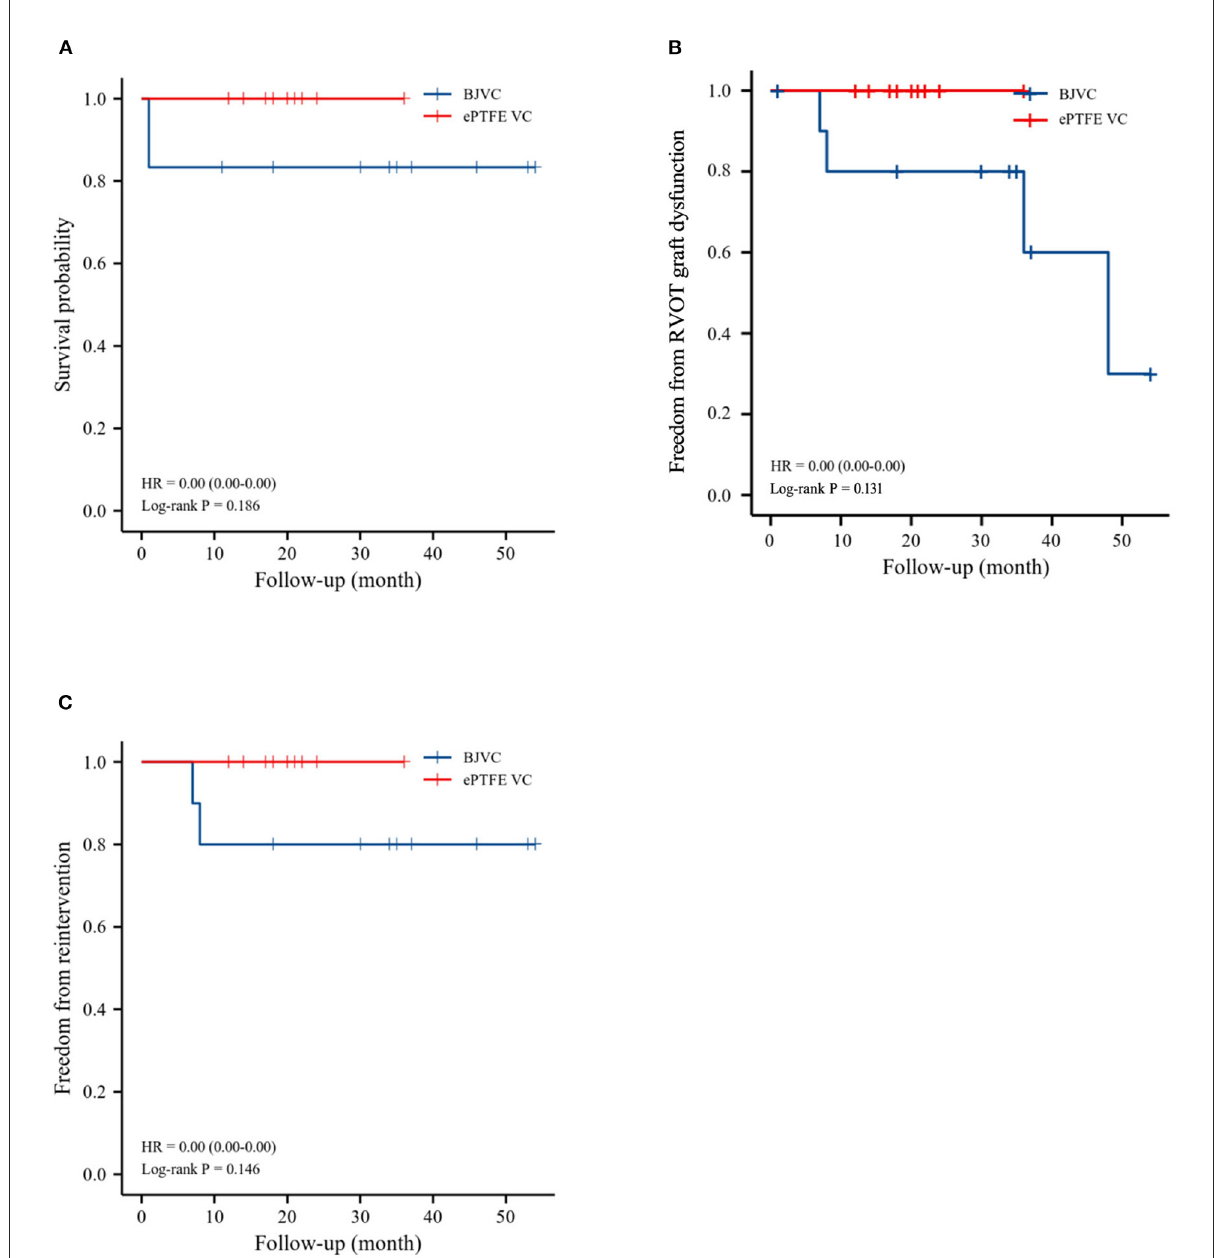
FIGURE2 Outcomes of survival, freedom from RVOT reintervention, and freedom from RVOT graft dysfunction, as evaluated by Kaplan–Meier method. (A) . Survival. (B) . Freedom from RVOT graft dysfunction. (C) . Freedom from